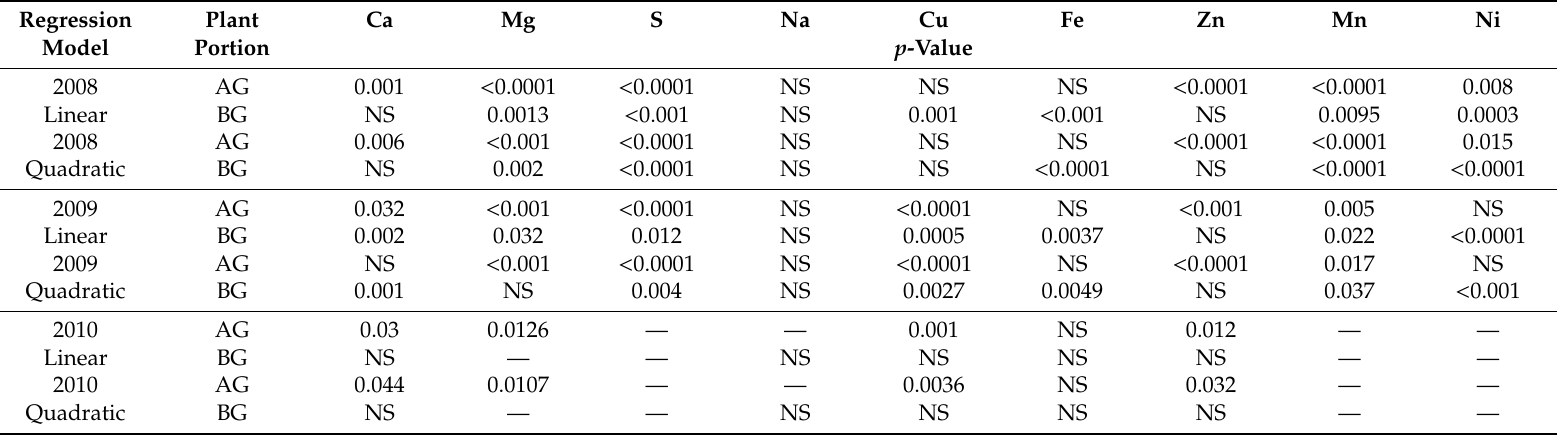
Table 4. Significance levels of regression models on nutrient movement through the plant (above ground (AG) and belowground (BG) portions) as a function of di ff erent stand ages (AGDD: accumulated growing degree